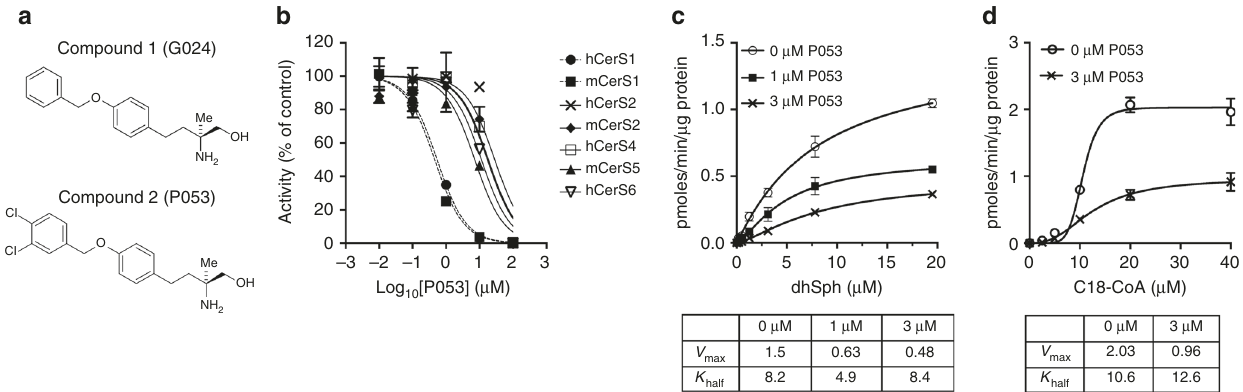
Fig. 1 P053 is a selective inhibitor of CerS1. a Structure of G024 [1] and P053 [2]. b Activity of CerS isoforms as a function of P053 concentration ( n = 3 for each concentration, mean ± SEM). c , d CerS1 activity as a function of c dihydrosphingosine or d C18:0-CoA concentration. Calculated V max and K half values are below the graphs. Graphs show mean ± SEM ( n = 3 for each concentration), and the non-competitive inhibition was con fi rmed in three independent experiments for each